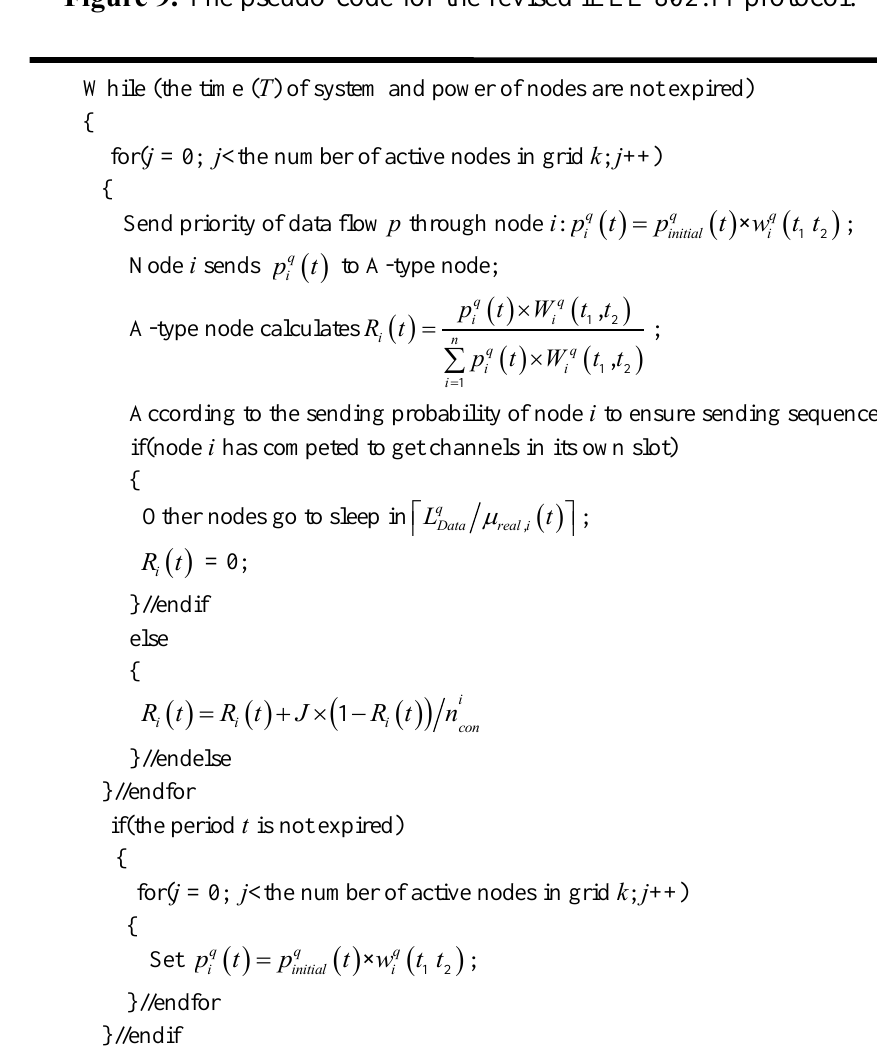
Figure 9. The pseudo-code for the revised IEEE 802.11